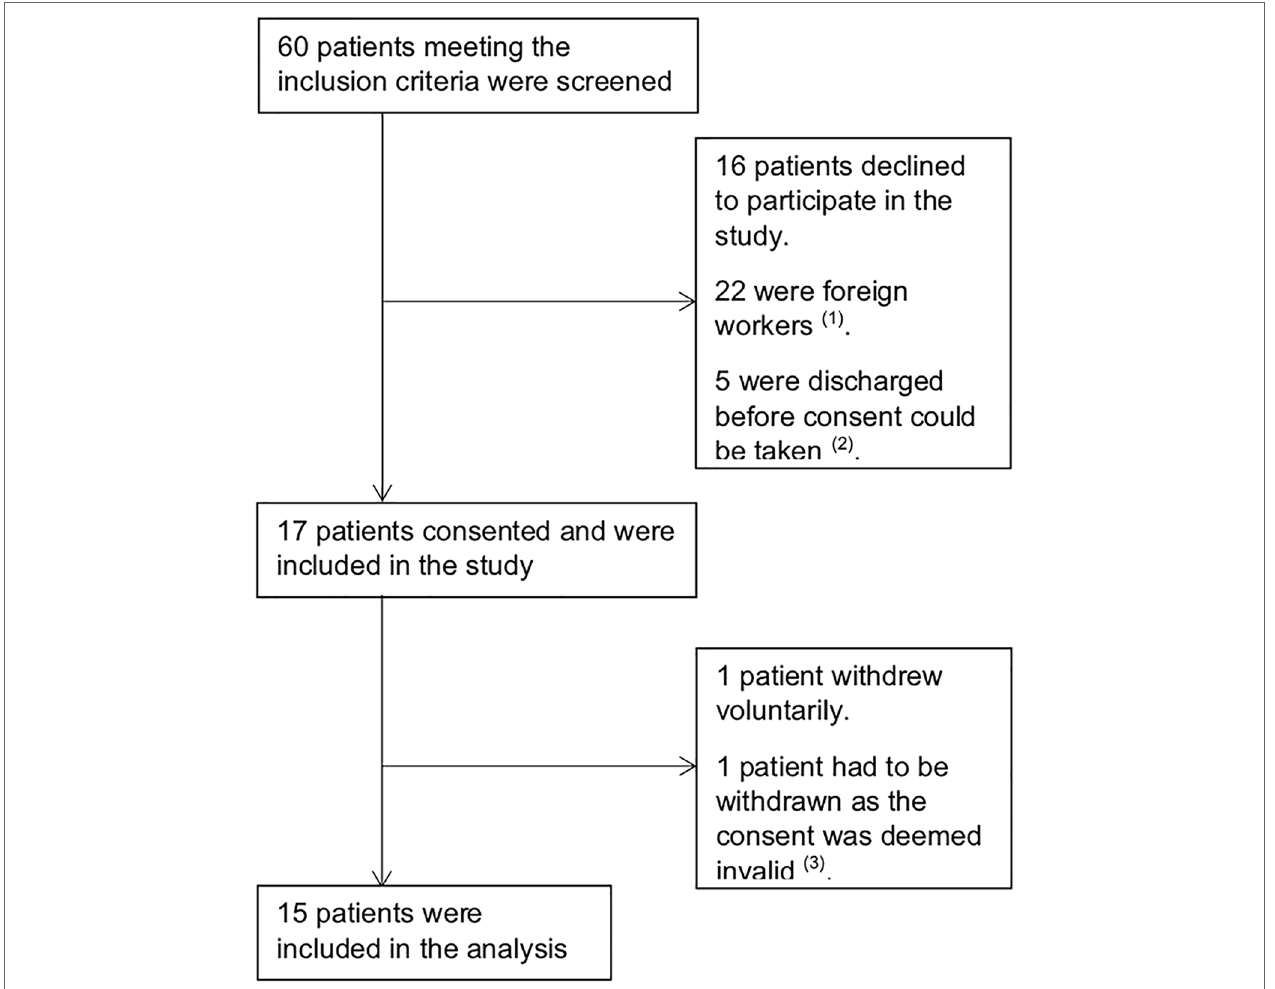
FiGURE 1 | Trial Profile. (1) Foreign workers, typically domestic helpers and laborers, were excluded as they were repatriated back to their home country as soon as clinically stable and long-term follow up would not have been possible. (2) These patients were not able to provide consent as they were unwell and no legally acceptable representative was available. (3) Consent for this patient was obtained after baseline assessments were completed. As such, the authors decided to withdraw the patient’s data from the